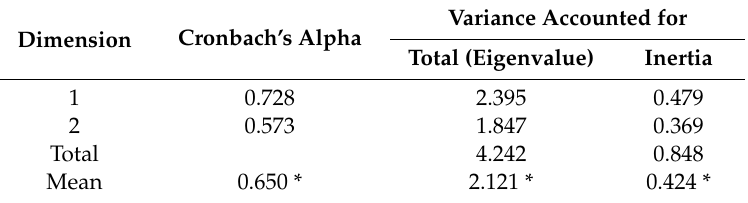
Table 6. Summary of the model inferred from multiple correspondence